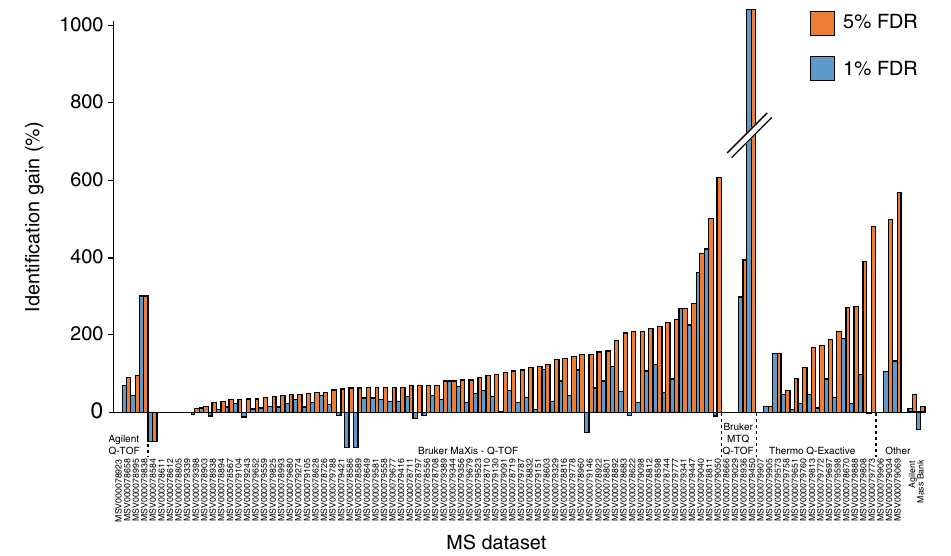
Fig. 3 FDR based annotations for 70 metabolomics projects. These are projects from human, microbes, plants, marine-organism, and other derived metabolomics data. The plot shows the percent gain in annotations for each of the data sets in GNPS-MassIVE at 1% and 5% FDR in relationship to the mass spectrometer used. A plot sorted by sample characteristic is provided as Supplementary Fig. 7. The impact on identi fi cation rates with the MassBank and Agilent data sets are shown on the